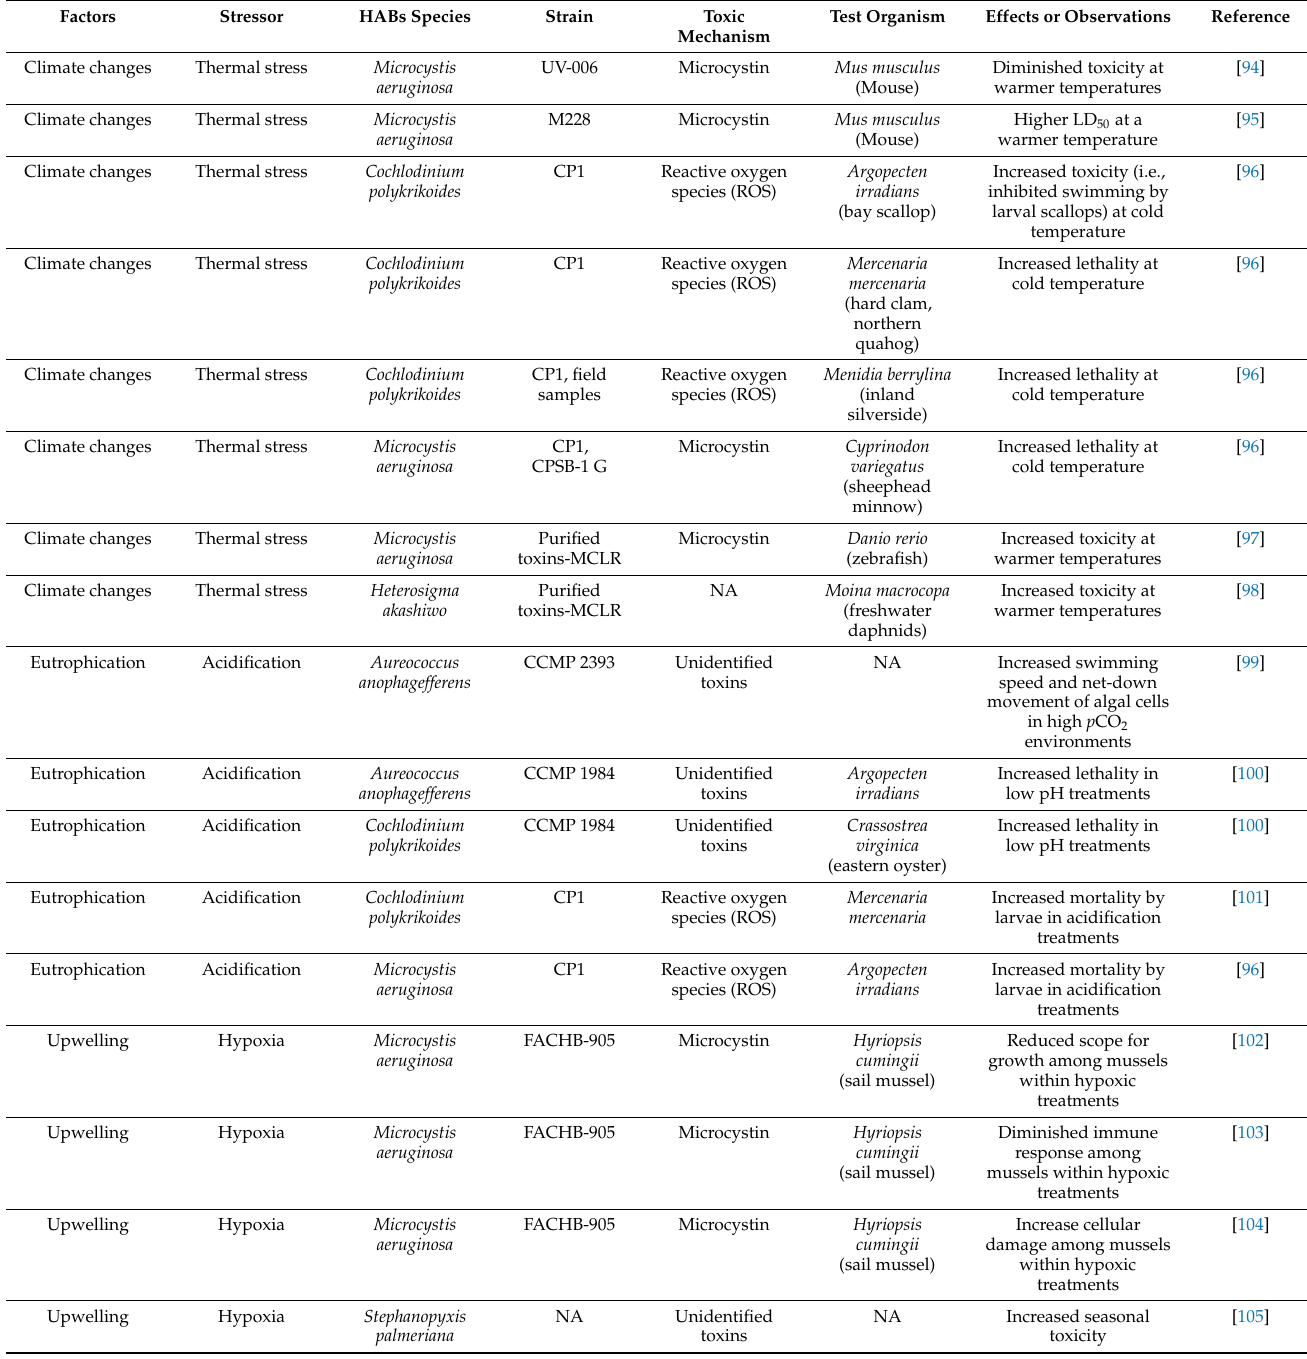
Table 1. Summary of known interactions between marine and freshwater harmful algal blooms and other